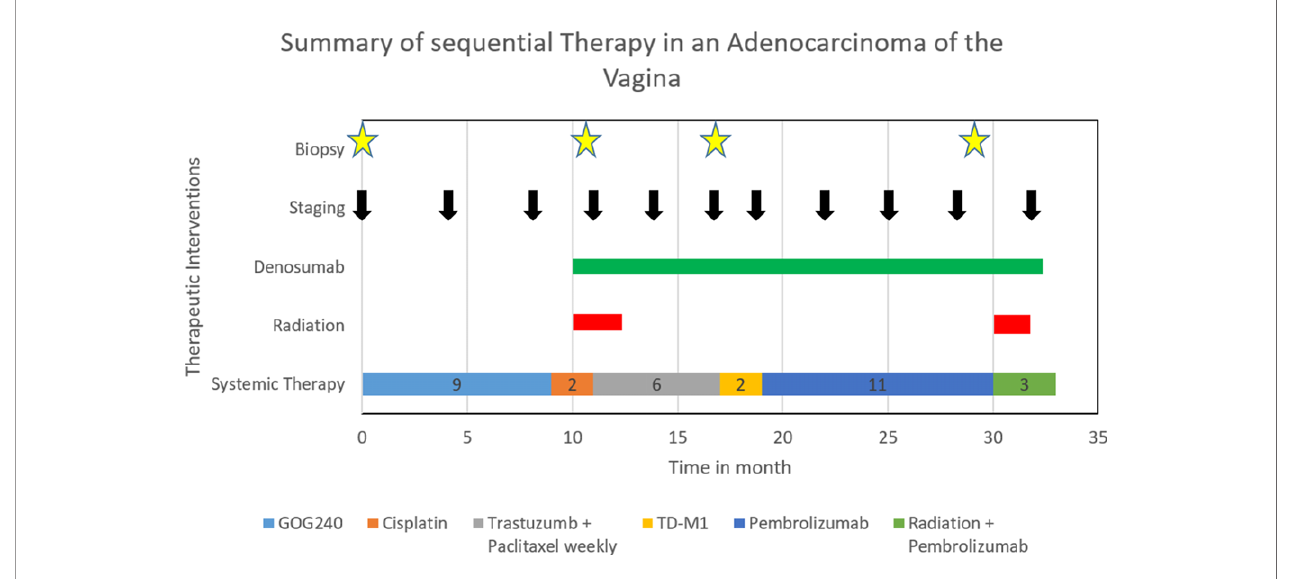
FIGURE 3 | Summary of sequential therapy in an adenocarcinoma of the